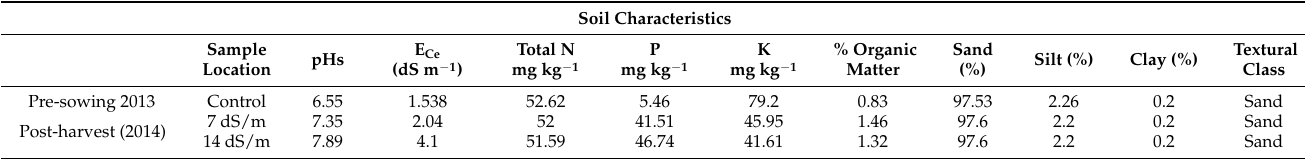
Table 2. Physical and chemical characteristics of experimental soil. Soil